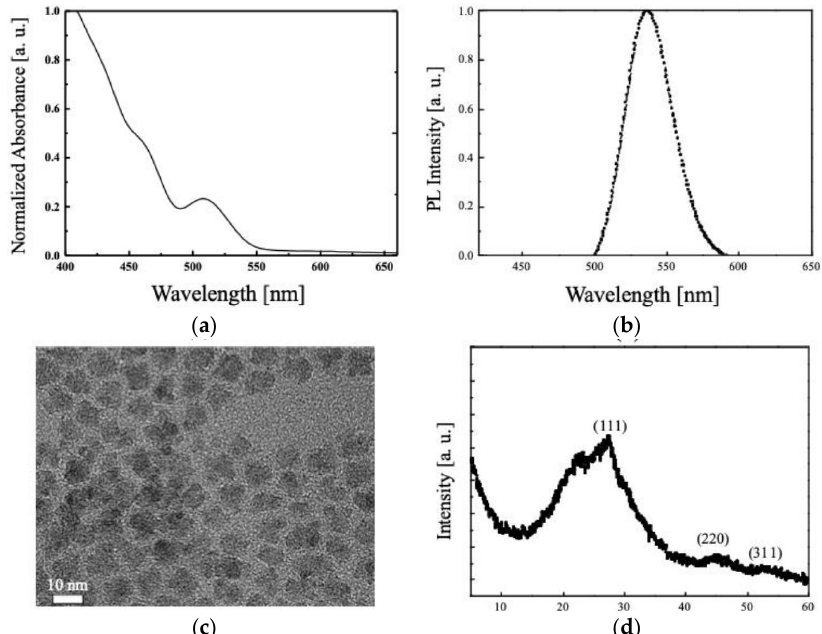
Figure 4. The measured results: ( a ) photoluminescence (PL) characteristics, ( b ) absorbance properties, ( c ) transmission electron microscopy (TEM) image, and ( d ) X-ray diffraction (XRD) spectrum of synthesized quantum dots (QDs).